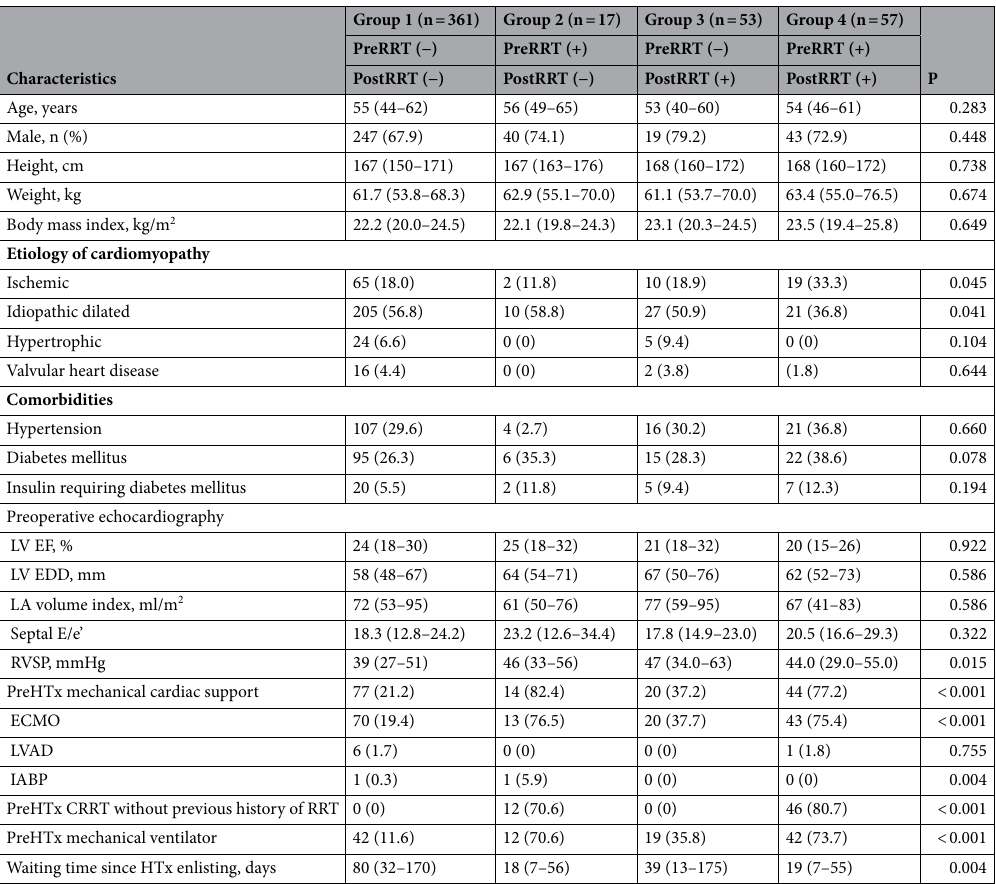
Table 1. Pre- and postoperative characteristics of patients who underwent isolated HTx according to perioperative RRT support. Data were expressed as median (IQR) or number (%). RRT renal replacement therapy, DM diabetes mellitus, LV left ventricle, eGFR estimated glomerular filtration rate, HTx heart transplantation, LV left ventricle, EF ejection fraction, EDD end-diastolic dimension, LA left atrium, E early mitral inflow velocity, e ′ early mitral tissue Doppler velocity, RVSP right ventricular systolic pressure, ECMO extracorporeal membrane oxygenation, LVAD left ventricular assisting device, IABP intra-aortic balloon pump, RRT renal replacement therapy, EF ejection fraction, LV left ventricle, EDD end-diastolic dimension, CRRT continuous renal